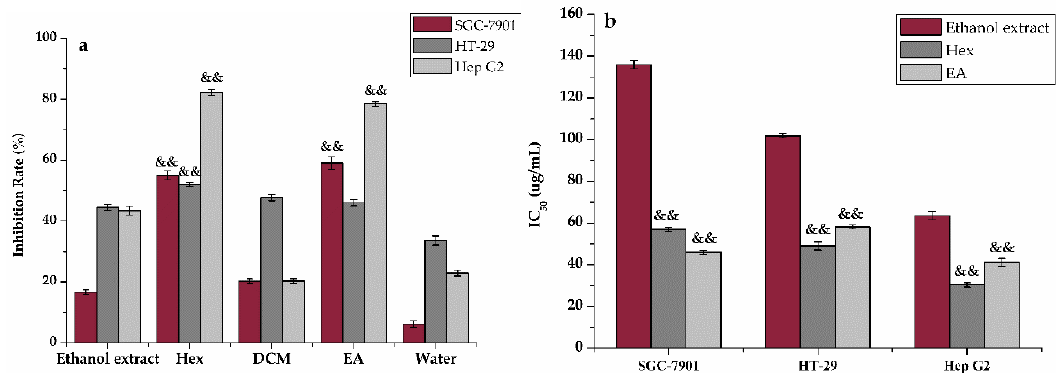
Figure 4. Anti-proliferative activity of the ethanol extract, Hex, DCM, EA, and water fractions of H. abyssinica : ( a ) The inhibition ratio of SGC-7901, HT-29, and HepG2 cells treated by the ethanol extract, Hex, DCM, EA, and water fractions of H. abyssinica ; and ( b ) The IC 50 value of the ethanol extract, Hex, and EA. All of the values in the figure are expressed as means (%) and standard deviation of triplicate experiments. && p < 0.01, as compared with the ethanol extract.